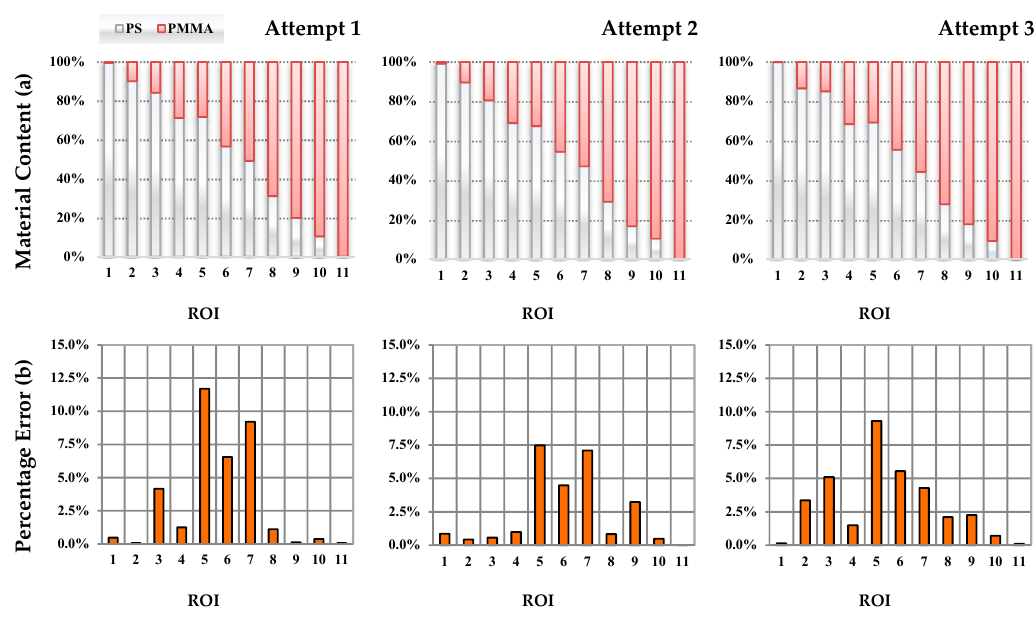
Figure 9. Percentage of material ( a ) and error in estimation ( b ) in chosen segments (three attempts). The values of an error with respect to the base values were determined for each attempt. Its